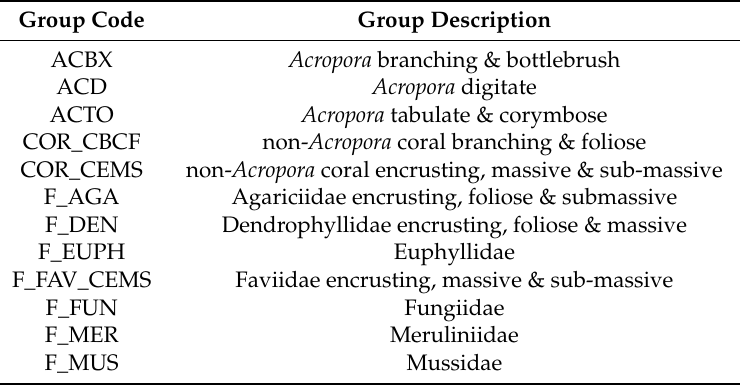
Figure 1. Coral community disassembly and reassembly across the continental shelf of Australia’s Great Barrier Reef. ( A ) Location of survey reefs, ( B ) hard coral community disassembly following coral cover decline (N = 144) and ( C ) coral community reassembly following coral cover recovery (N = 207) on inner-shelf (I), mid-shelf (M) and outer-shelf reefs (O). On ( B ) and ( C ), the y-axis represents the Bray–Curtis distance (dissimilarity) between disturbed and pre-disturbance community composition. ∆ HC (%) represents the difference between the maximum coral cover observed at each reef and the coral cover measured at that reef in any given year. Envelopes show 95% credible intervals from the posterior distributions estimated from the Bayesian hierarchical model. Table 1. Hard coral groups surveyed and associated